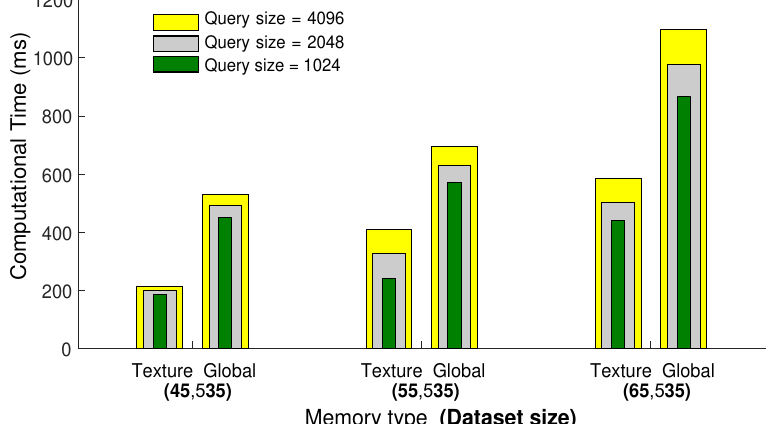
Figure 5. The comparison between the texture and global memories regarding elapsed computa- tional time. For this experiment, K NNs is fixed to be 64, and the computational time is measured in